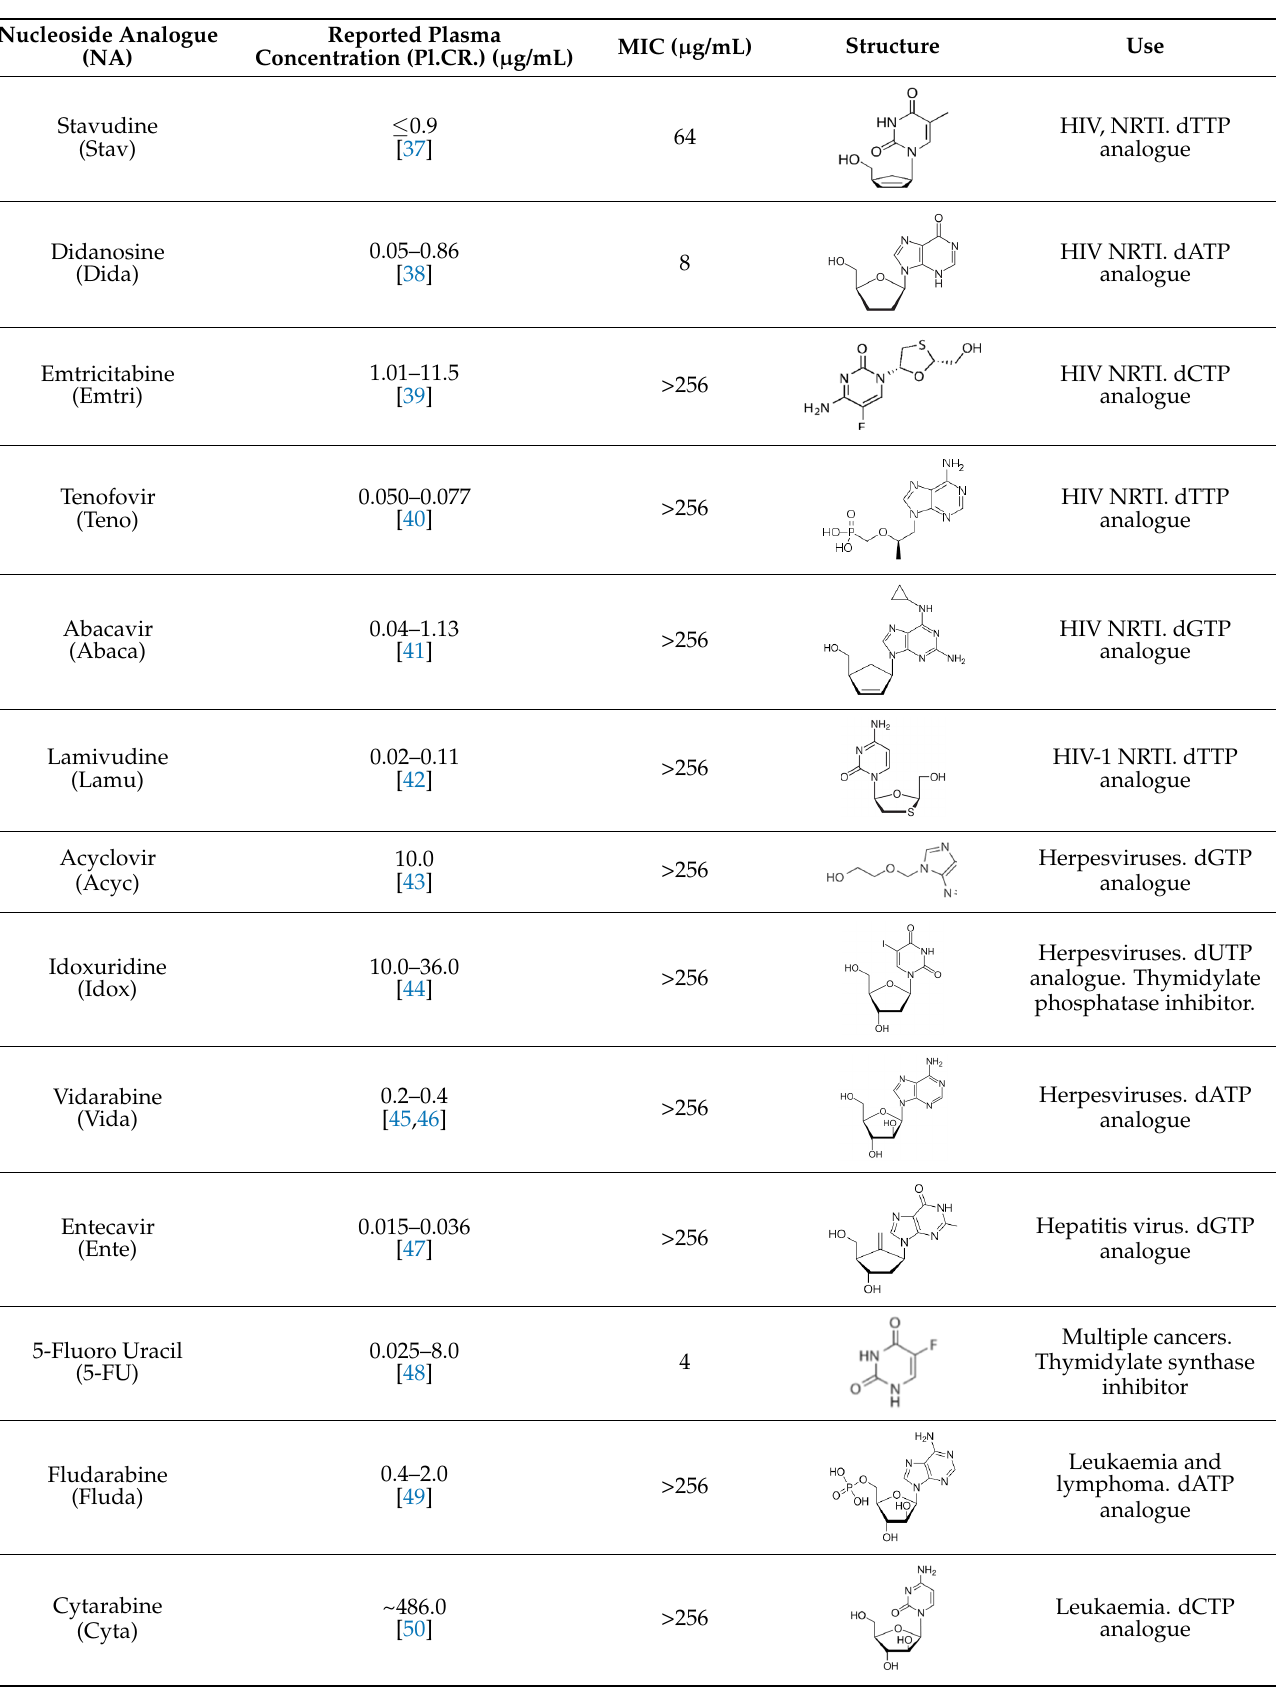
Table 1. Nucleoside analogues (NAs) and their minimal inhibitory concentrations (MICs) in Escherichia coli MG1655. Nucleoside Analogue Reported Plasma (NA) Concentration (Pl.CR.) ( µ g/mL)